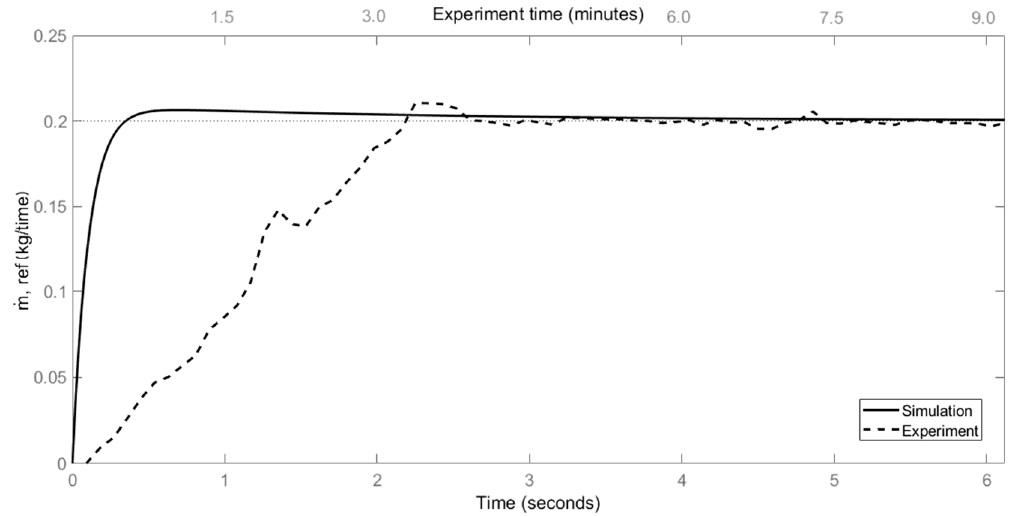
Figure 10. Response of the expansion valve with PID 2.